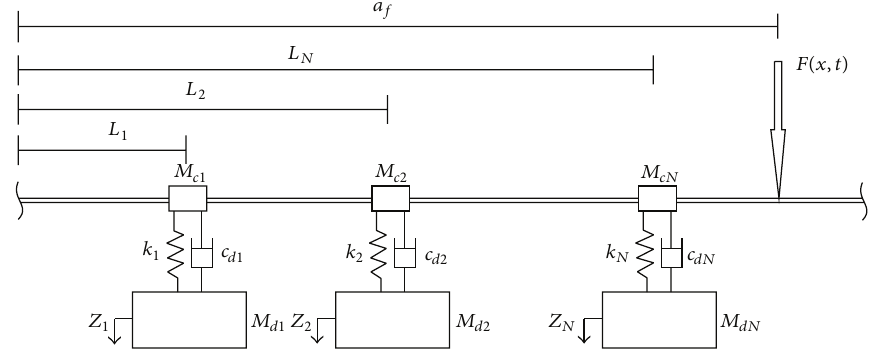
Figure 1: Schematic of an axial beam carrying several mass-spring-damper-mass